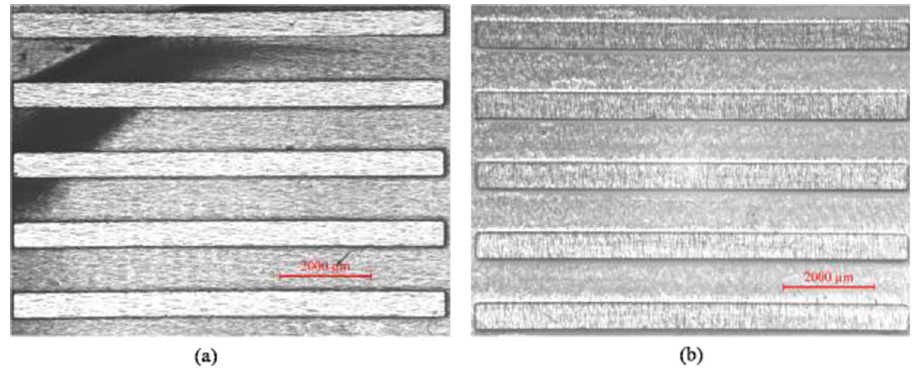
Fig. 7. (a) Unused mask and (b) mask after being used 26